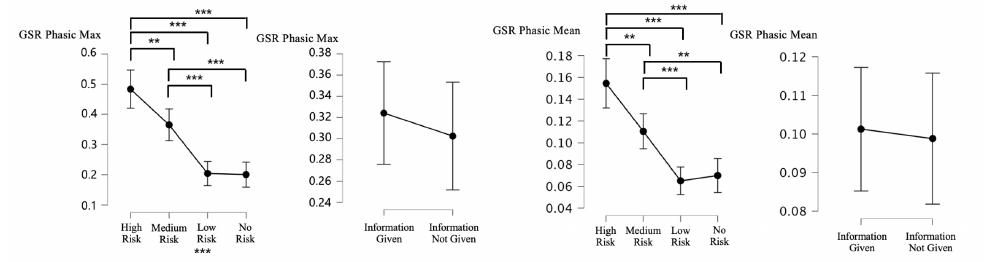
Figure 5. A graph that compares the maximum, mean, and accumulation value of GSR phasic data according to risk level and whether or not information was provisioned through HUD. The use of asterisks in the figure indicates statistical significance. Two (**) denotes a p -value less than 0.01, while three (***) asterisks denote p -values less than 0.001,